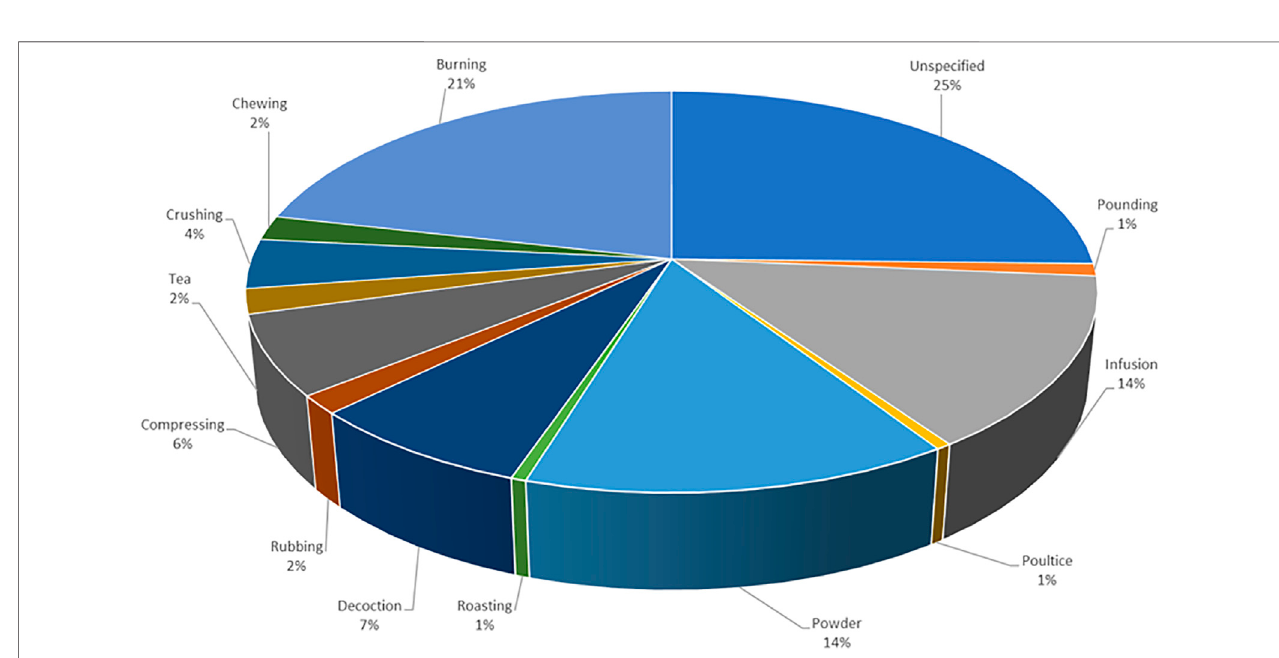
FIGURE 3 | Different methods of preparation for medicinal plants ( n = 215). Out ofthe 186 medicinal plants recorded, several had ˃ 1 method used for preparation.